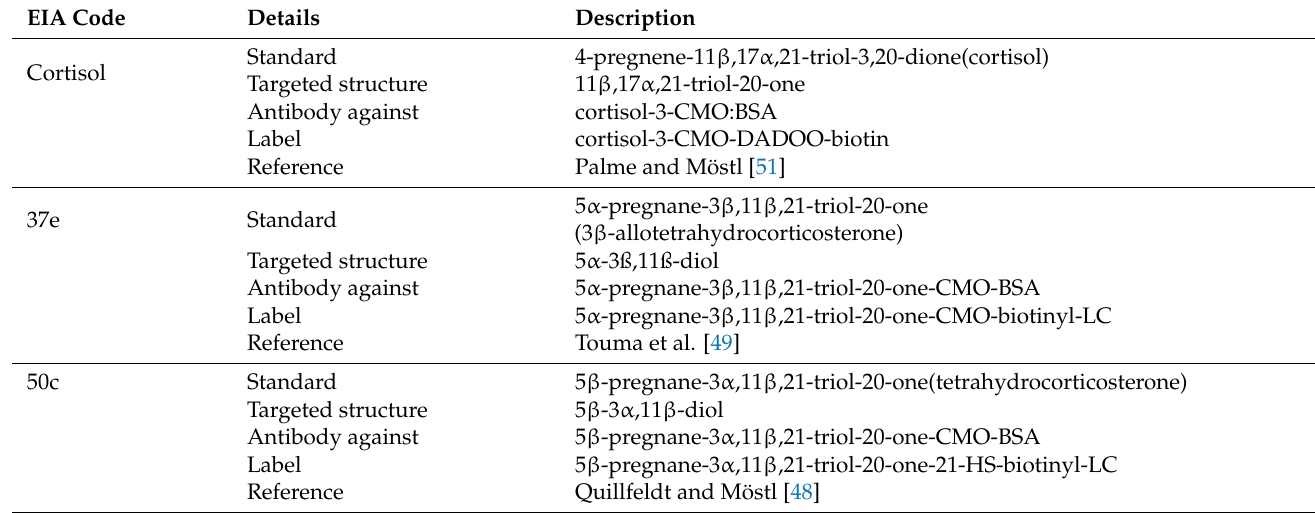
Table 1. Details of the EIAs (enzyme immunoassays) utilized in the current